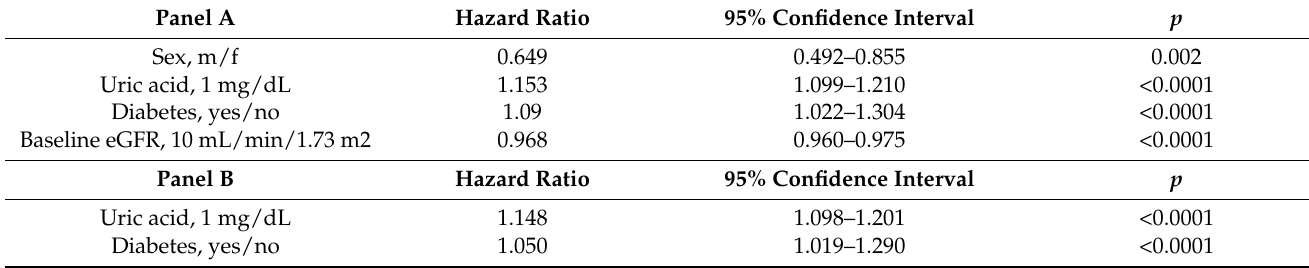
Abbreviations: eGFR, estimated glomerular filtration